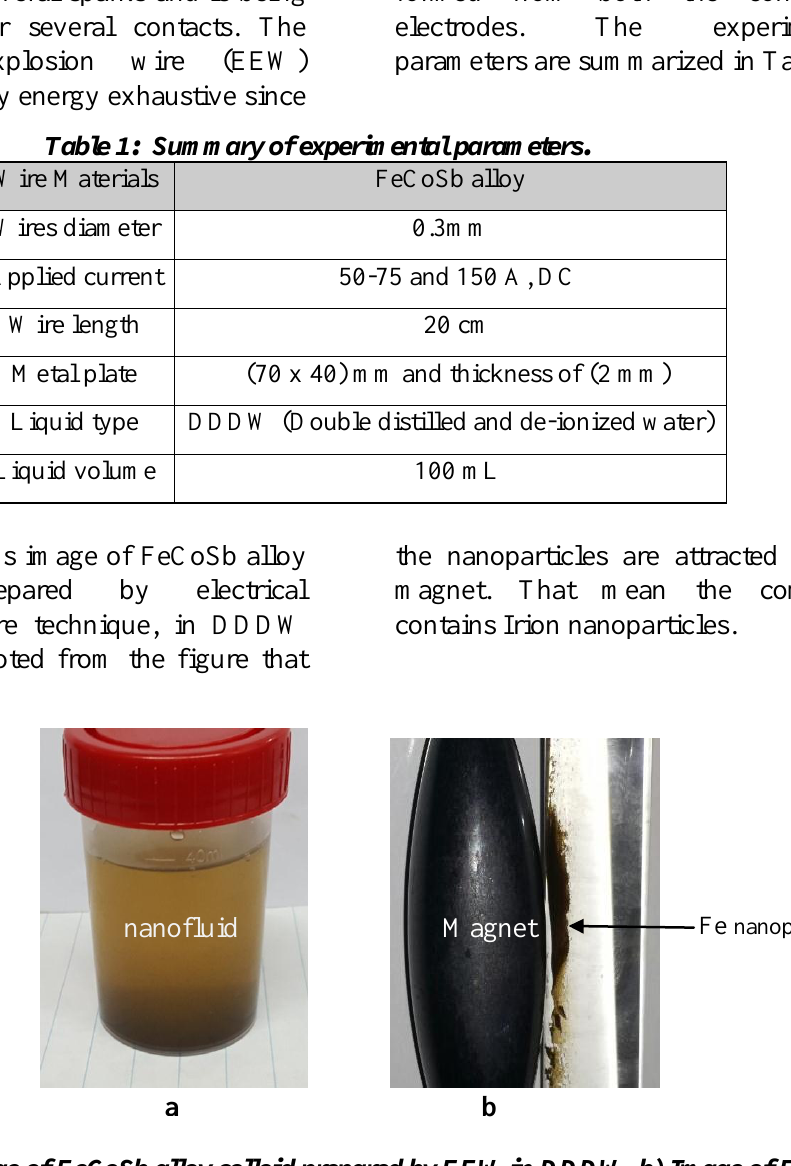
Fig. 2: a) Image of FeCoSb alloy colloid prepared by EEW in DDDW. b) Image of FeCoSb nanoparticles which attracted to the